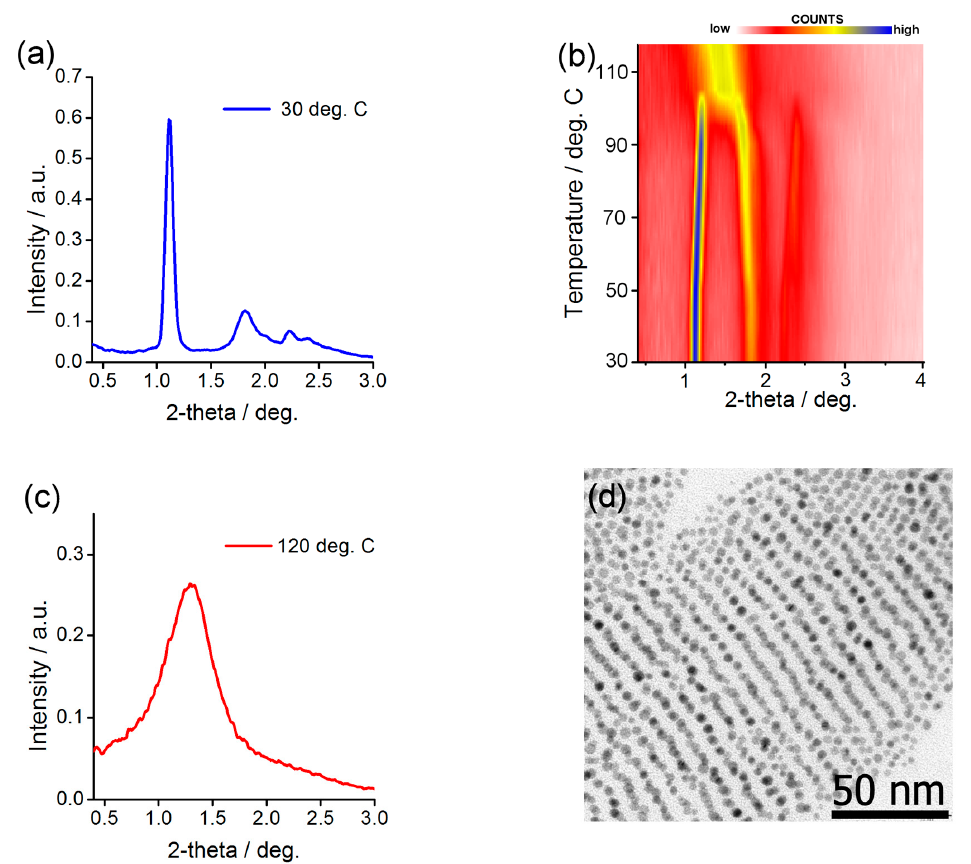
Figure 4. Structural investigation of Au@L1/C12 nanoparticles. ( a , c ) SAXRD profiles for low and high temperature structures (panels a, c, respectively) ( b ) Temperature evolution of SAXRD patterns taken for annealed sample and ( d ) corresponding TEM image.